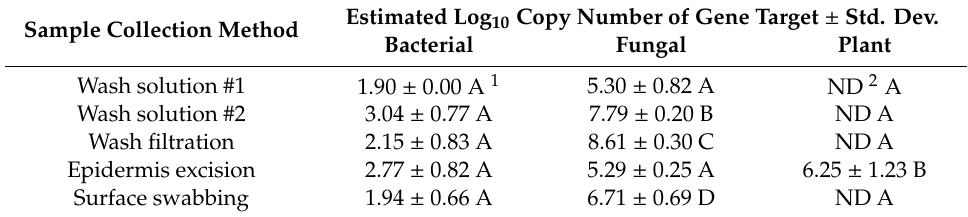
Table 4. Quantities of gene targets detected during quantitative (q)PCR by collection